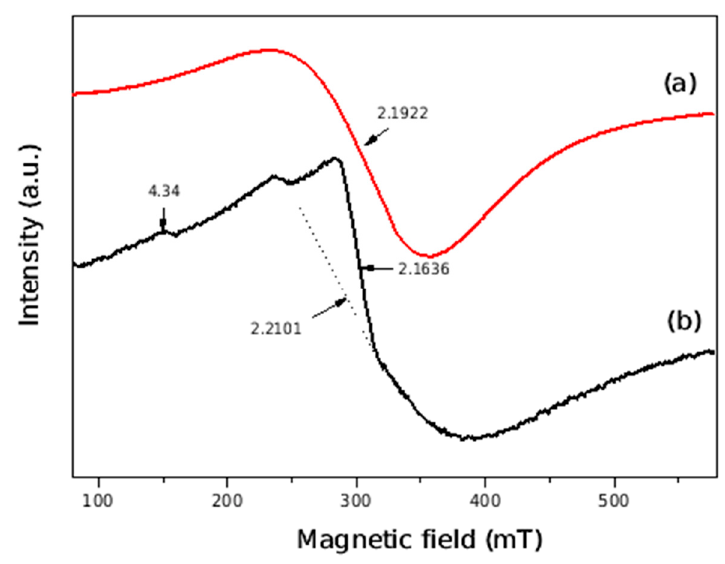
ever, because of overlapping of the signals, it is not possible to exactly identify the species.